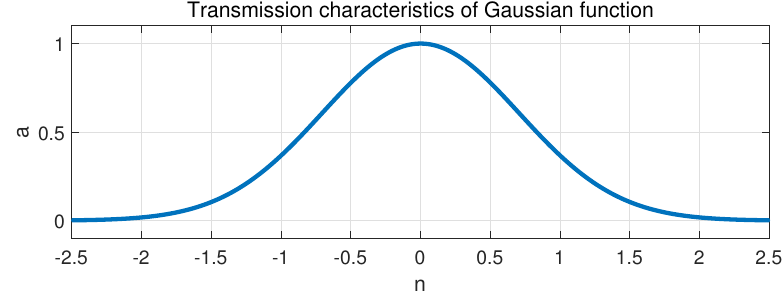
Figure 2. Gaussian function of RBF